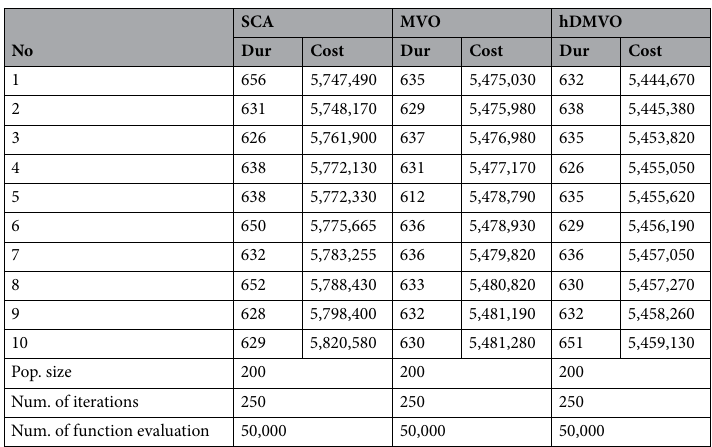
Table 9. Analysis results of problem 63a.